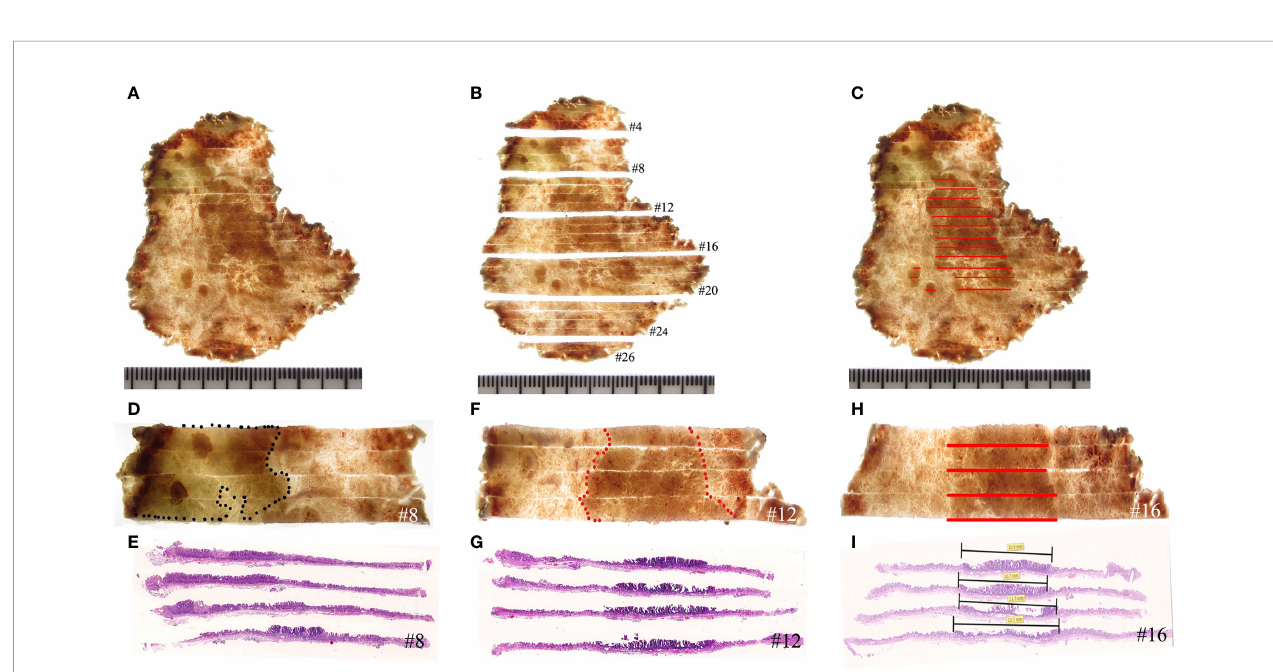
FIGURE 5 | Histological mapping and corresponding hematoxylin and eosin-stained sections. (A – C) The photographic image is taken after cutting and sectioning the specimen. Each section is numbered to make mapping and reconstruction possible. Finally, the histopathology of each section is projected onto the macroscopic image, and topographic mapping on the endoscopic submucosal dissection specimens demonstrates three discrete areas of early cancer. (D, E) The specimen with histological mapping shows that the region within the black dotted line is intrinsic acidic mucosa with hyperplastic and prolonged foveola, surrounded by atrophic gastric mucosa with incomplete intestinal metaplasia, which is consistent with the gastroscopic fi ndings. (F – I) Super fi cial elevation of the lesion is proven to be papillary adenocarcinoma by histology.